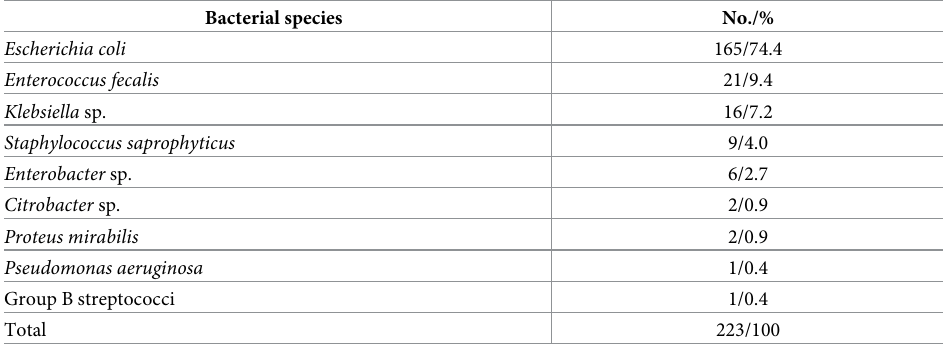
Table 2. Identified bacteria in samples in with significant